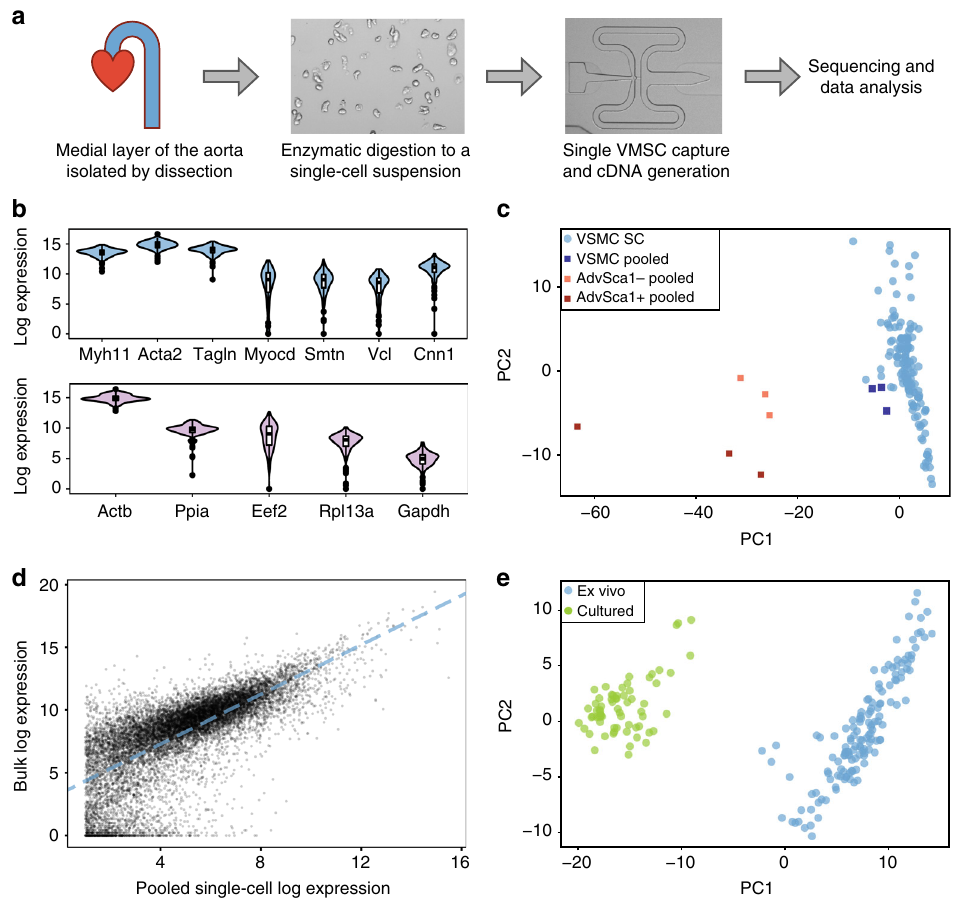
Fig. 1 Single-cell RNA-seq analysis of vascular smooth muscle cells. a Schematic of the approach. Cells from the medial layer are enzymatically digested to obtain a single-cell suspension. Single-cell cDNA libraries are then generated, followed by sequencing and data analysis. b Violin plots showing the log 2 - transformed normalised expression of VSMC marker genes across the pro fi led 143 cells (top), as well as of housekeeping genes with similar mean expression levels (lower panel). c Mapping of single-cell VSMC transcriptomes (light blue), as well as transcriptomes from control VSMC (Sca1 – , dark blue) and adventitial (Adv) cell (Sca1 – , orange; Sca1 + , red) samples (tube controls) on a two-dimensional PCA space. d Dot plot showing the log 2 - transformed read counts detected for each gene (black dots) when pooling across all single-cell samples versus the read counts detected with bulk RNA- seq. The dashed line shows a linear regression fi t. e PCA plot summarising the single-cell expression pro fi les for ex vivo VSMCs (blue) and in vitro cultured VSMCs (green, data from Gene Expression Omnibus accession GSE79436, Adhikari et al. 13